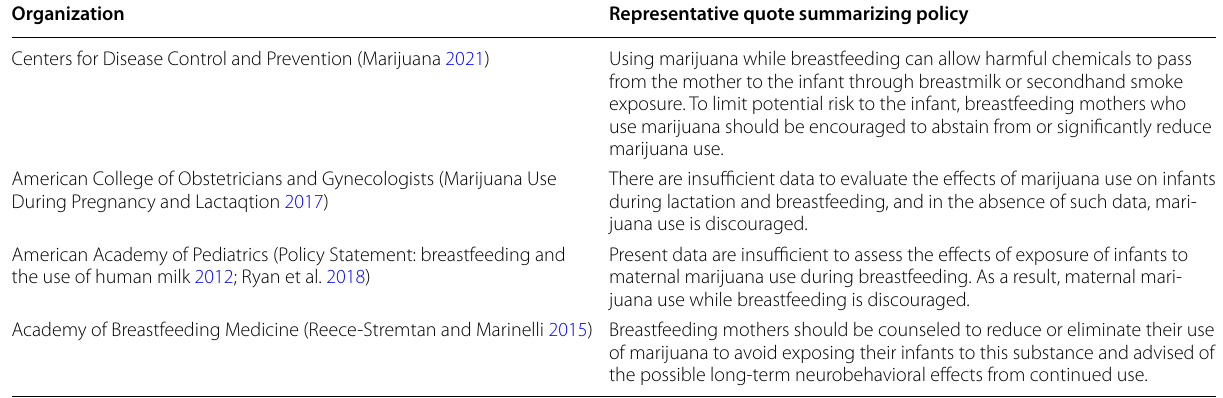
Table 1 National guidelines for breastfeeding in the setting of marijuana